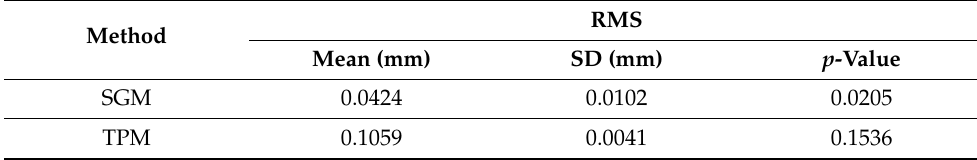
Table 1. Trueness of SGM and TPM